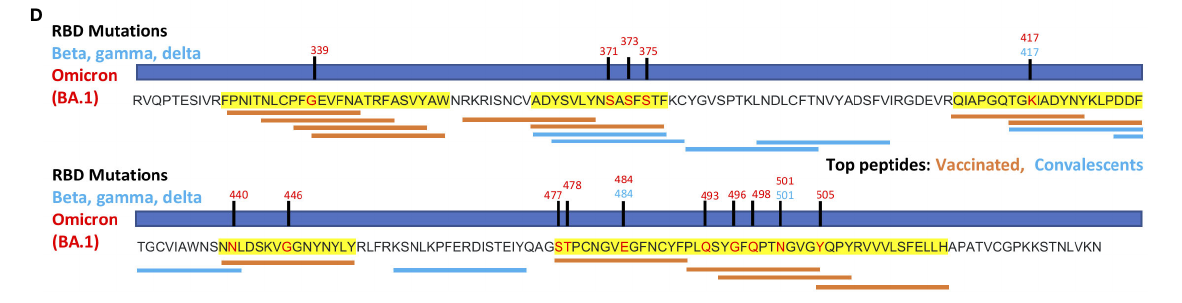
FIGURE 7 Structural evaluation of topmost recognized peptides among vaccinated and analysis of occurrence at mutation sites. (A) RBD binding to the therapeutic neutralizing antibody COVA1-16 (pdb:7JMW) and with ACE-2 (B) interacting with P14/18, the most recognized region, with contact amino acid residues in black. SARS-CoV-2 RBD (light gray). Colored regions show the most frequently recognized peptides identi fi ed among vaccinated. (C) Timeline showing collection period of samples, vaccination and surge of VOCs in Brazil. (D) Linear RBD sequence showing mutation sites of Beta, Gamma, Delta and Omicron BA.1. Regions highlighted in yellow are the most recognized among vaccinated. Top thirteen from vaccinated (orange) and top seven (blue) IgG recognized peptides are shown according to RBD